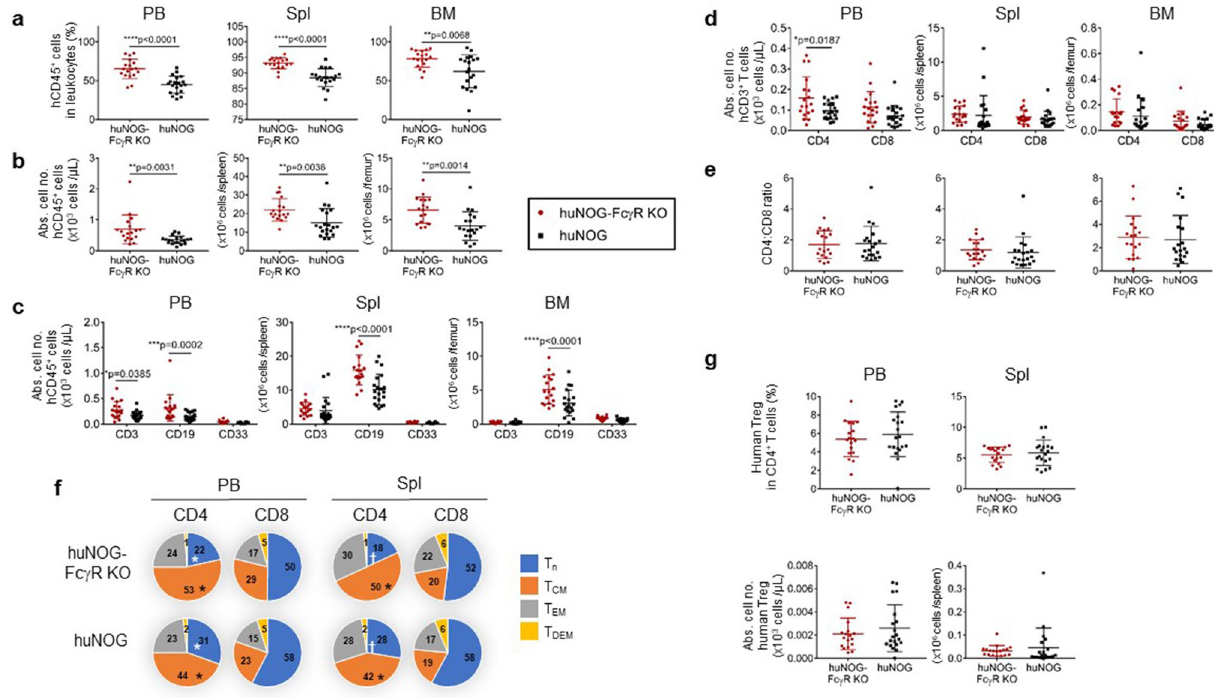
Figure 2. Characteristics of human immune cells in NOG-FcγR −/− mice. Flow cytometry analysis of huNOG and huNOG-FcγR −/− mice at 18 weeks after HSC transplantation. Mononuclear cells from PB, spleen, and BM were examined. ( a , b ) The frequencies ( a ) and numbers ( b ) of human CD45 + cells in the indicated tissues. Cumulative results from two independent experiments are shown with the average and SD bars. ( c , d ) The numbers of human CD3 + T cells, CD19 + B cells, CD33 + myeloid cells ( c ), and T-cell subpopulations (CD4 + and CD8 + ) ( d ) are shown. ( e ) Ratios of CD4 + to CD8 + T cells from ( d ). ( f ) Subpopulations in CD4 + and CD8 + T cells. T cells were subdivided into T n (CD45RA + CD62L hi ), T CM (CD45RA - CD62L hi ), T EM (CD45RA - CD62L lo ), and T DEM (CD45RA + CD62L lo ) based on the expression of CD45RA and CD62L. The average frequencies of each subpopulation were calculated from flow cytometry data (Supplementary Fig. 2) and depicted in pie charts. ( g ) The frequencies and numbers of human Tregs. Tregs were identified as FOXP3 + CD25 + CD45RA - CD4 + cells detected by intracellular staining 45 and the data from individual mice are plotted with the average and SD bars. The numbers of huNOG and huNOG- FcγR −/− mice were 20 (19 for BM analysis) and 18, respectively. Asterisks, or a pair of symbols indicate statistical significance in ( a – d ), or in ( f ), respectively. The p-value was obtained using two-tailed Student’s t -test between huNOG and huNOG-FcγR −/− mice [*p < 0.05, **p < 0.01, ***p < 0.001, ****p < 0.0001 in ( a – d ), and *p < 0.05, † p < 0.01 in ( f